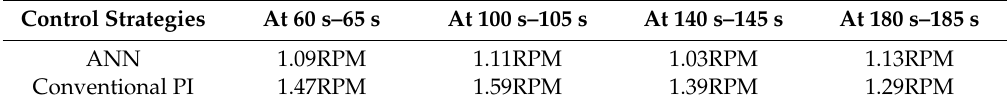
Figure 13. Reference tracking performance comparison between diffident control strategies, red line: Speed feedback value, green line: Reference model 𝑦 𝑟 (𝑘) , brown line: control signal 𝑦(𝑘) , blue line: Evolution of the errors for the rotational speed. ( a ) The initial control performance with RDNN; ( b ) The steady state control performance with RDNN; ( c ) The steady state control performance with PID. Table 1. Error variance comparison between PI and neural controllers during the steady state operation. Control